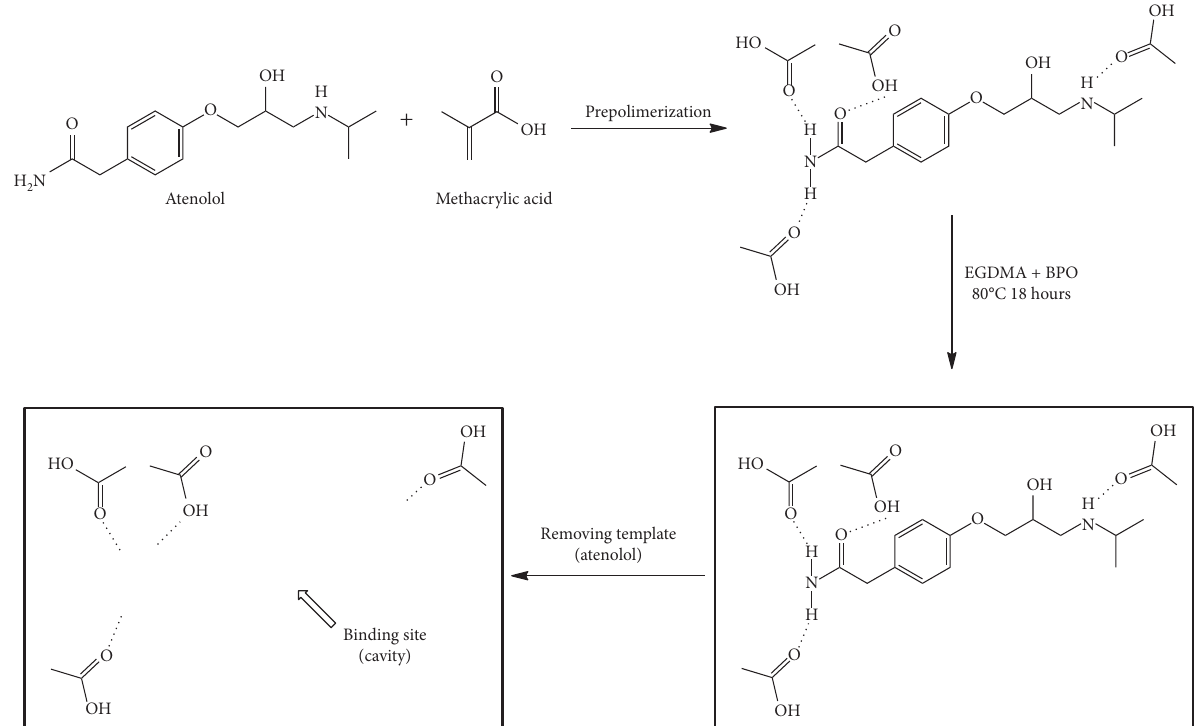
Figure 3: Illustration of the synthesis of the imprinted monolithic